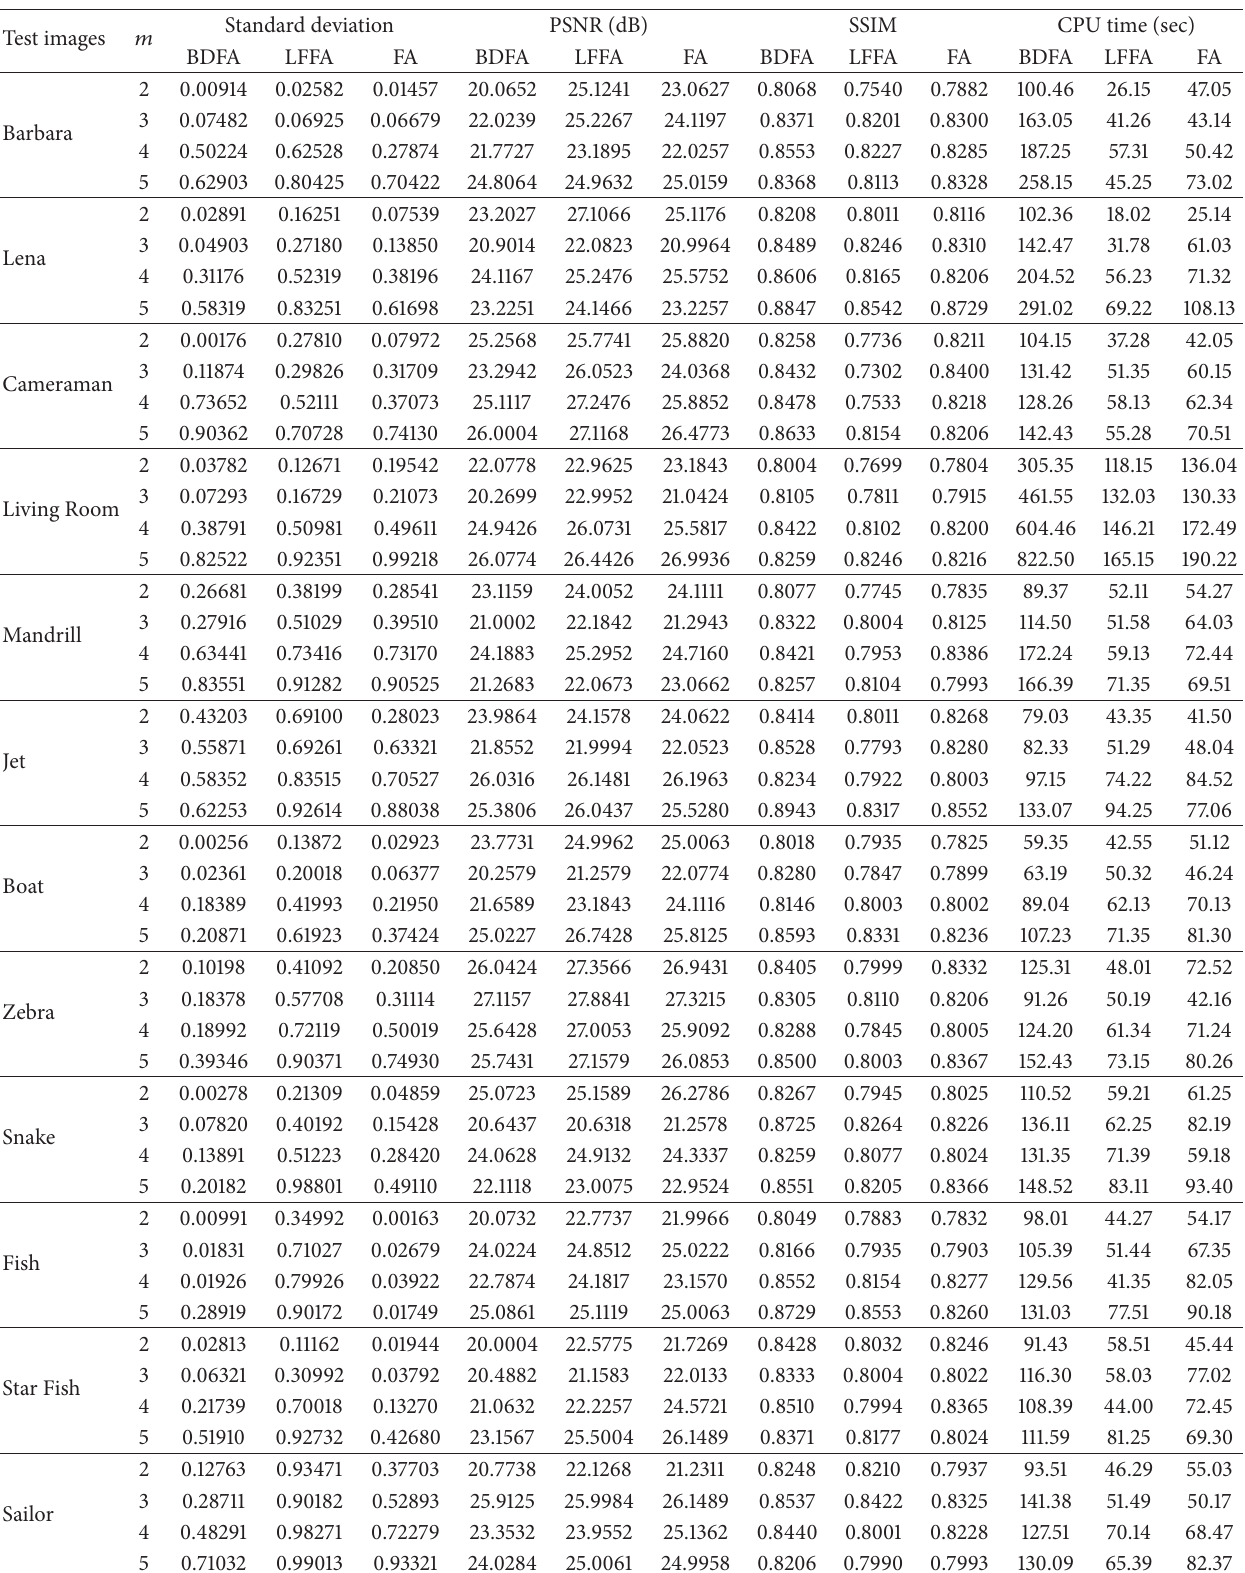
Table 2: Comparison of the standard deviation, PSNR, SSIM, and CPU time obtained for test images. Test